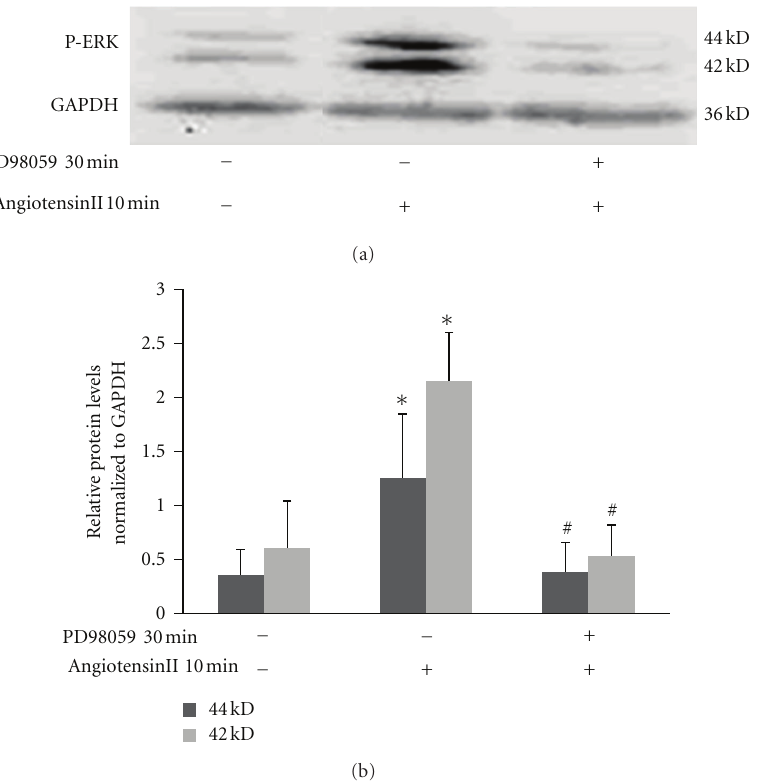
Figure 3: The e ff ects of PD98059 on ERKs phosphorylation in cultured CMVECs. CMVECs were incubated with (+) or without ( − ) PD98059 (50 μ M), an ERKs inhibitor, for 30 min and then treated with (+) or without ( − ) AngII (10 − 7 M) for 10min. Thereafter, the cells were collected and lysed for western blotting. (a) Representative immunoblots showing the expression of phosphor ERKs. GAPDH was used as a loading control. (b) Quantitative analysis for the expression of phosphor ERKs. Data represent mean ± SD obtained from 4 independent experiments ( n = 4). ∗ P < 0 . 05 versus CMVECs with neither PD98059 nor AngII treatment; # P < 0 . 05 versus CMVECs without PD98059 but with AngII